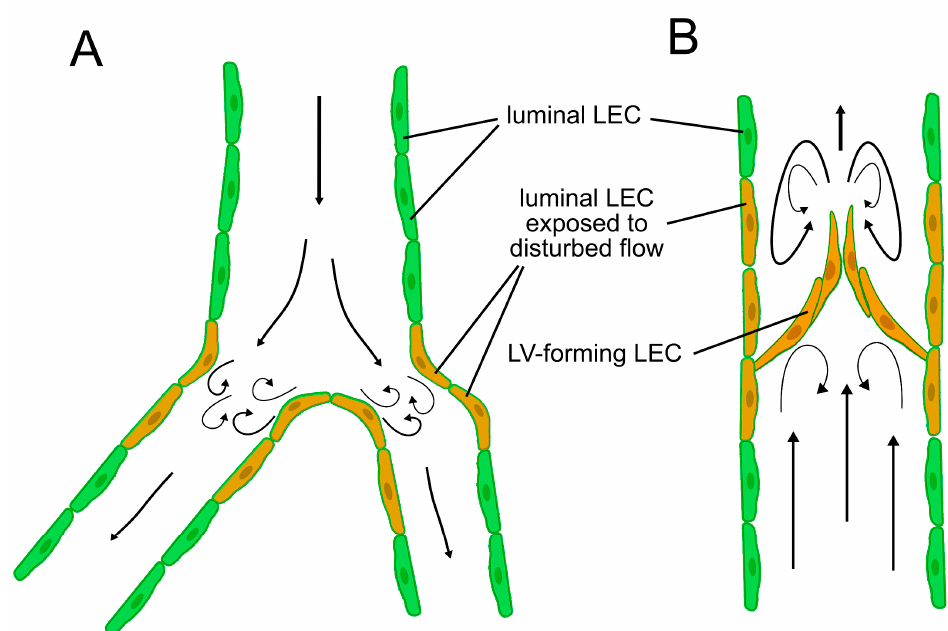
Figure 2. Flow patterns in the lymphatic system. ( A ) LECs in branches are exposed to disturbed flow patterns with higher shear stress even before the establishment of intraluminal valves. ( B ) Flow becomes disturbed at the lymphatic valves of mature collecting lymphatic vessels. Valve-forming LECs and luminal LECs surrounding lymphatic valves are also exposed to disturbed flow, while LECs at other sites than branches, valves, and curvatures are exposed to a more laminar flow.